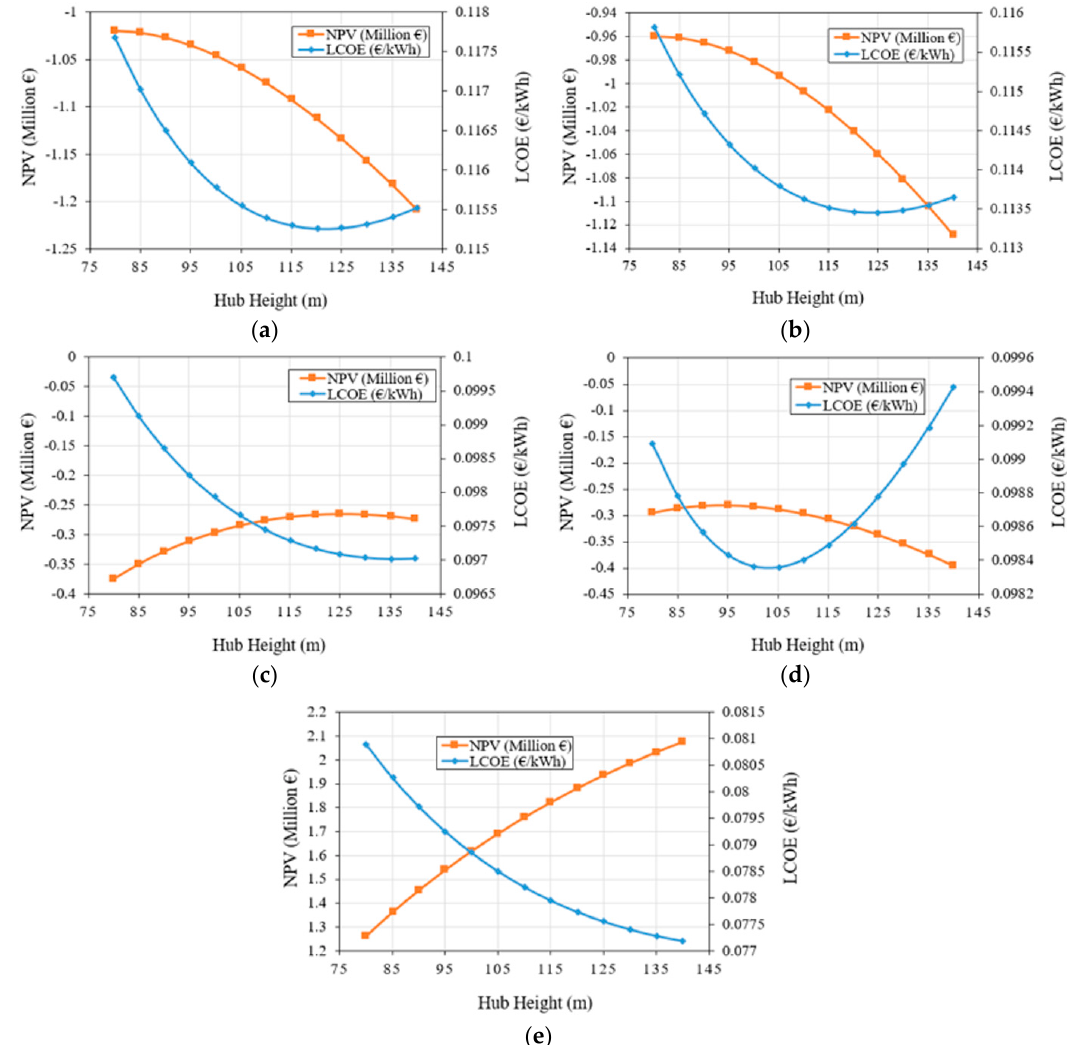
Figure 10. Effect of hub height on wind turbines economics at discount rate of 5% for Deokjeok-do ( a ) STX 93/2000; ( b ) U 93E/2000;( c ) U 113/2300; ( d ) HQ 93/2000; ( e ) WinDS 134/3000.